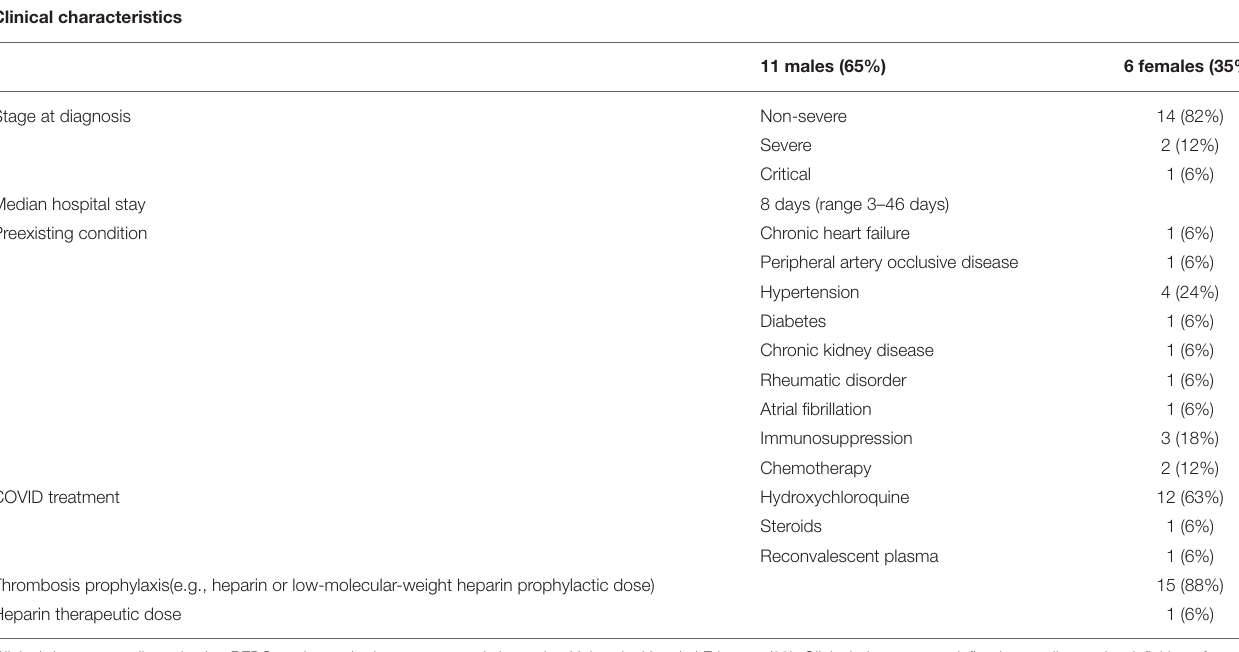
TABLE 4 | Clinical data of hospitalized patients with coronavirus disease 2019 (COVID-19) infection ( n = 17): preexisting condition, immunosuppressive medication (past 3 months), smoker, systemic therapy, thrombosis prophylaxis, clinical follow-up during hospitalization at the intensive care unit, and body mass index (BMI) ( n = 13). Clinical characteristics